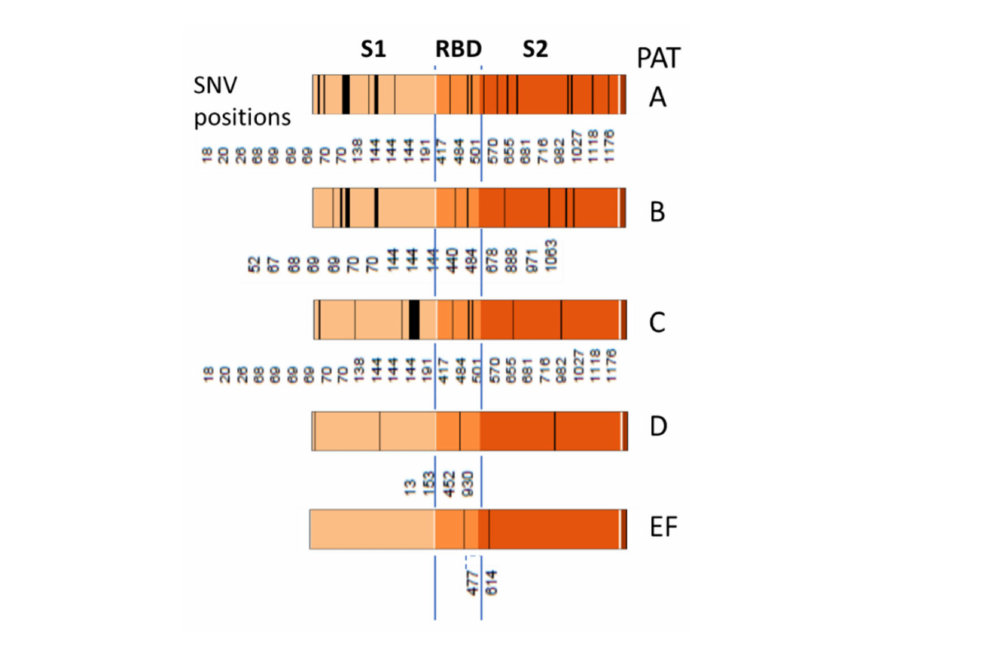
Figure A7. Mutations of the S-gene in the PAT’s. Position of the mutation is provided below the bars.